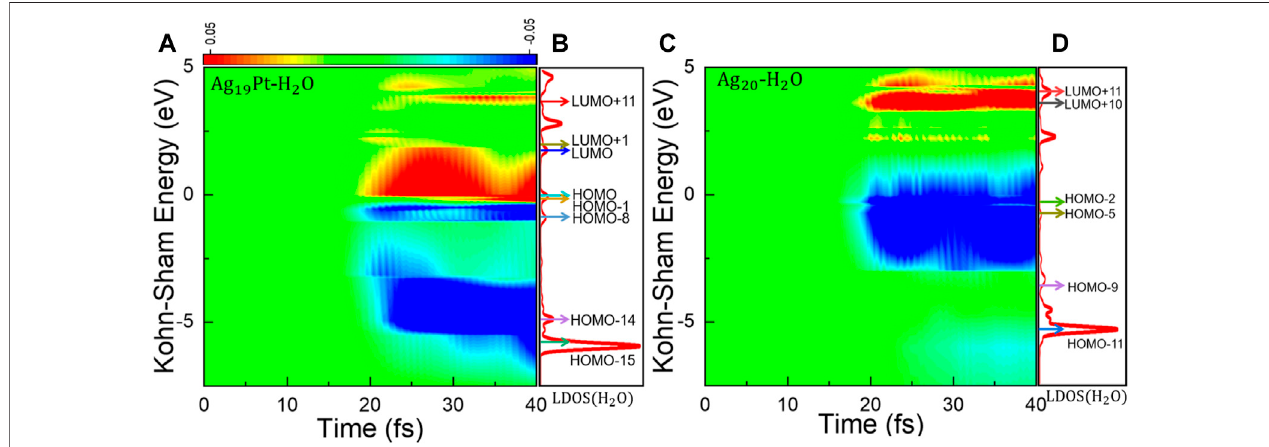
FIGURE 3 | Distribution of Kohn – Sham energy levels and changes in occupation. (A) Time-dependent changes in the occupation of the KS states and (B) projectedlocaldensityofstates(LDOS)ontheH 2 Ospeciesat t (cid:1) 0 fsforAg 19 Pt – H 2 Owitha fi eldstrengthof0.1 V/Å.Theeightarrowsfromthebottomtotopdenotethe energy levels of the eight KS states, that is, HOMO-15, HOMO-14, HOMO-8, HOMO-1, HOMO, LUMO, LUMO+1, and LUMO+11, respectively. (C) Time-dependent changesin the occupation ofthe KS states and (D) local projected density ofstates (LDOS) onthe H 2 Ospecies at t (cid:1) 0 fsfor Ag 20 – H 2 Ounder thesame condition. The six arrows from the bottom to top denote the energy levels of the six KS states, that is, HOMO-11, HOMO-9, HOMO-5, HOMO-2, LUMO+10, and LUMO+11, respectively.